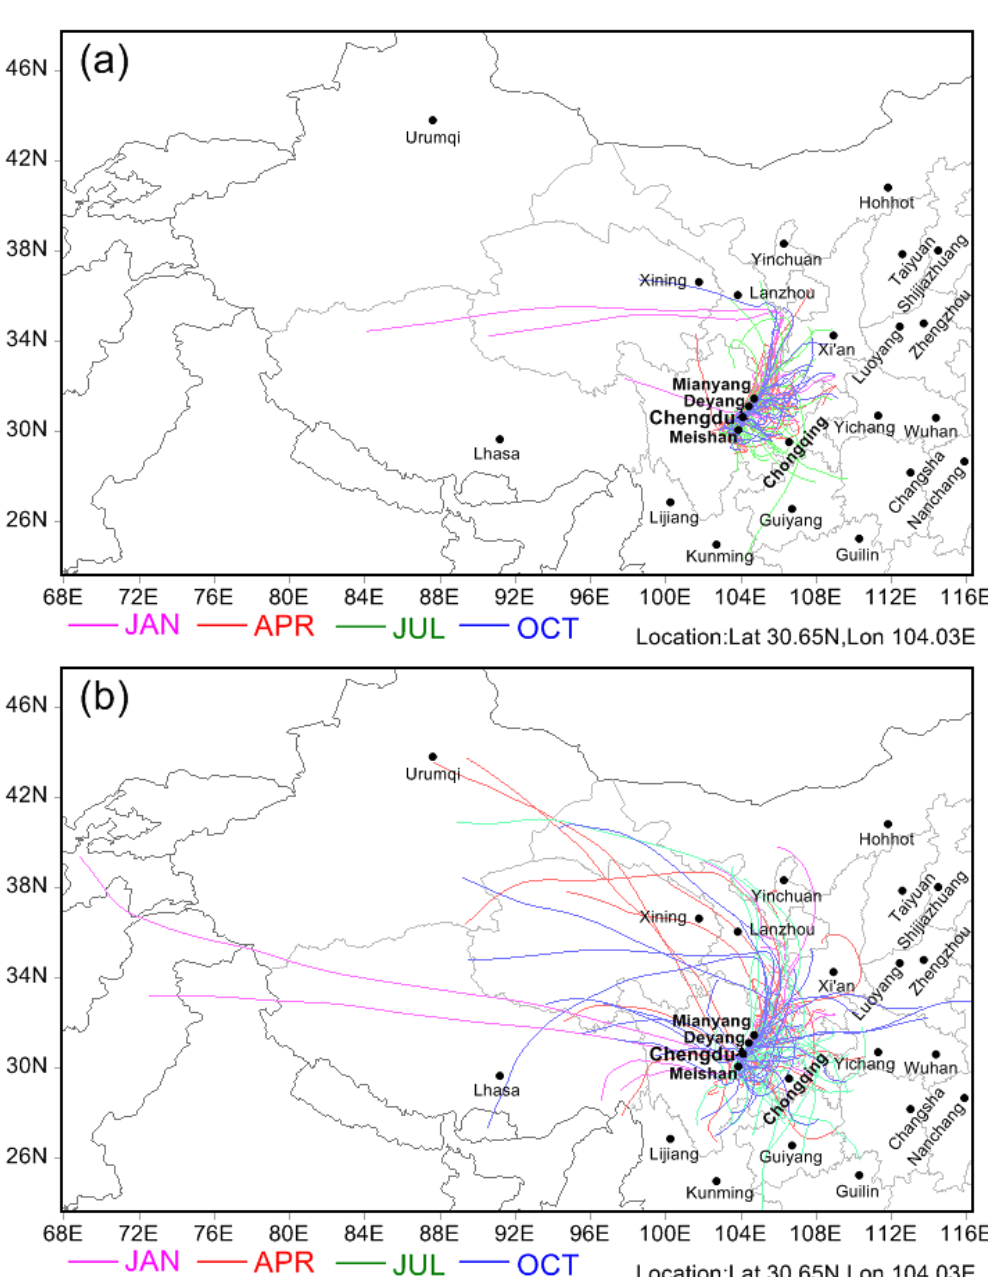
Figure 10. Analytical results of the 48h air mass back trajectories at 500m (a) and 1500m (b) elevation during the sampling periods, which were run four times per